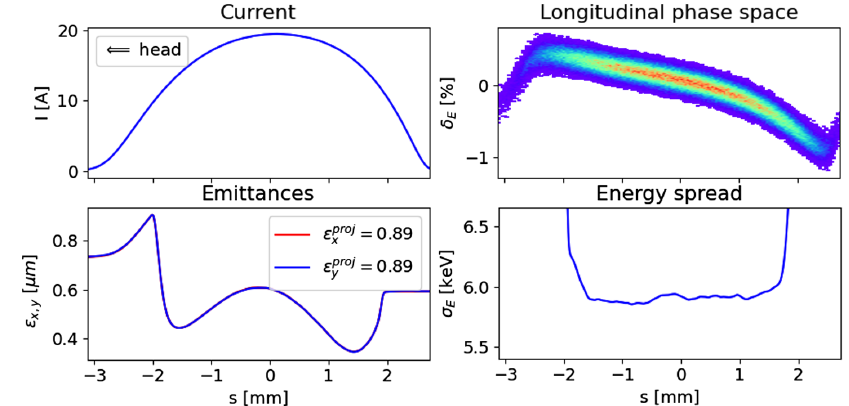
FIG. 5. Electron beam distribution after the gun used in the modeling.